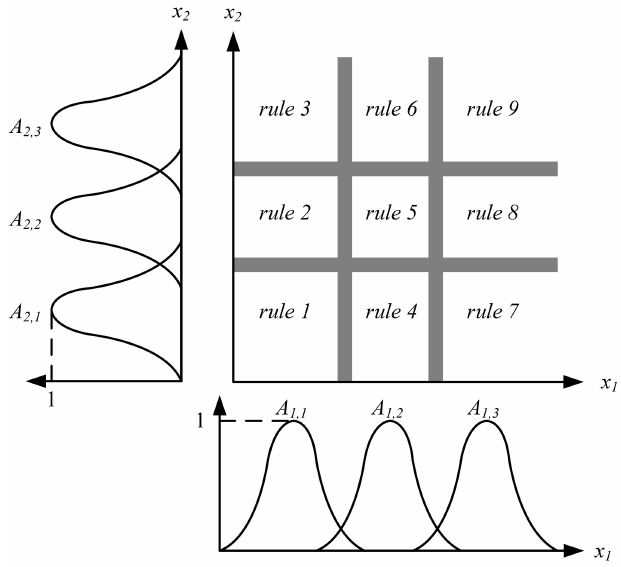
Figure 14. The input space divided into nine fuzzy